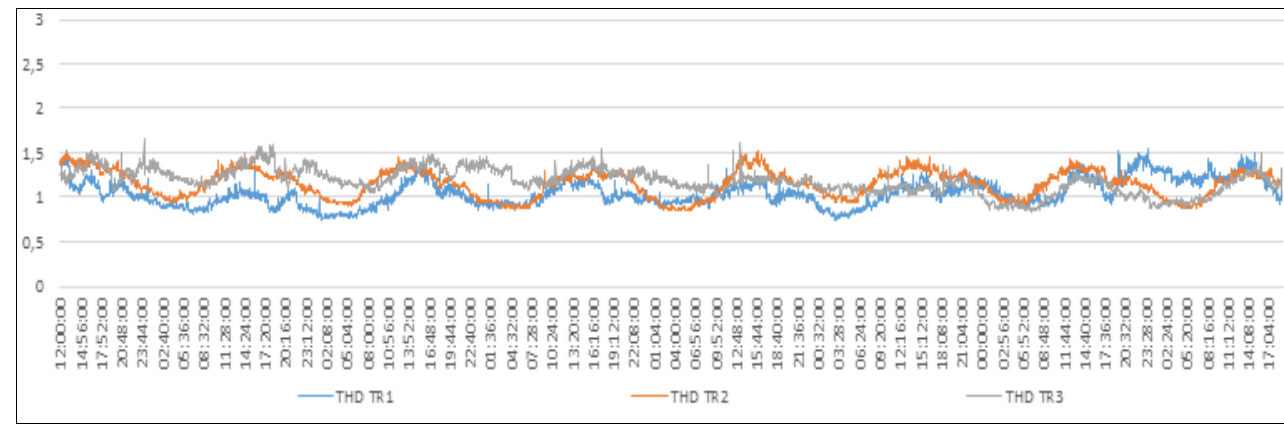
Figure 7: THD voltage phase “c” indicator graphic.